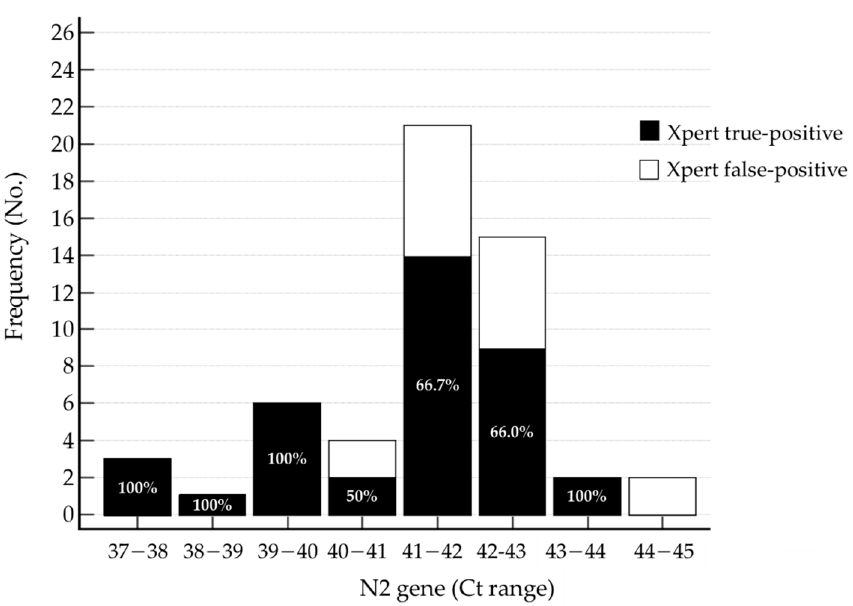
Figure 1. Xpert true-positive percentages according to the N2 gene Ct range (within a valid range, Ct value < 45) in E-gene-negative and N2-gene-positive samples. Abbreviations: Ct, cycle threshold; E, envelope gene; N2, nucleocapsid gene 2; SARS-CoV-2, severe acute respiratory syndrome coronavirus 2; Xpert, Xpert Xpress SARS-CoV-2 assay.